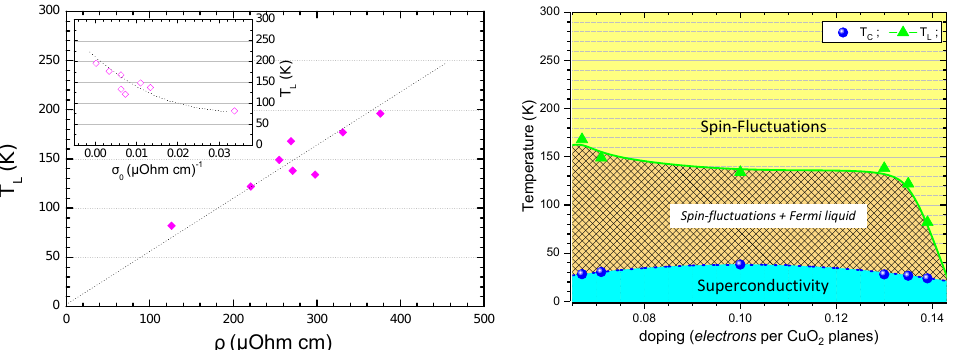
Figure 5. Left panel— T L dependence on the room temperature resistivity ρ . In the inset, T L is also plotted as a function of the residual conductivity σ 0 . Right panel—Doping evolution of the temper- ature phase diagram of electron doped cuprates. The experimental values of the superconducting temperature T c and the temperature T L at which the curves are no longer purely linear are reported. The different regimes are qualitatively indicated by colors and